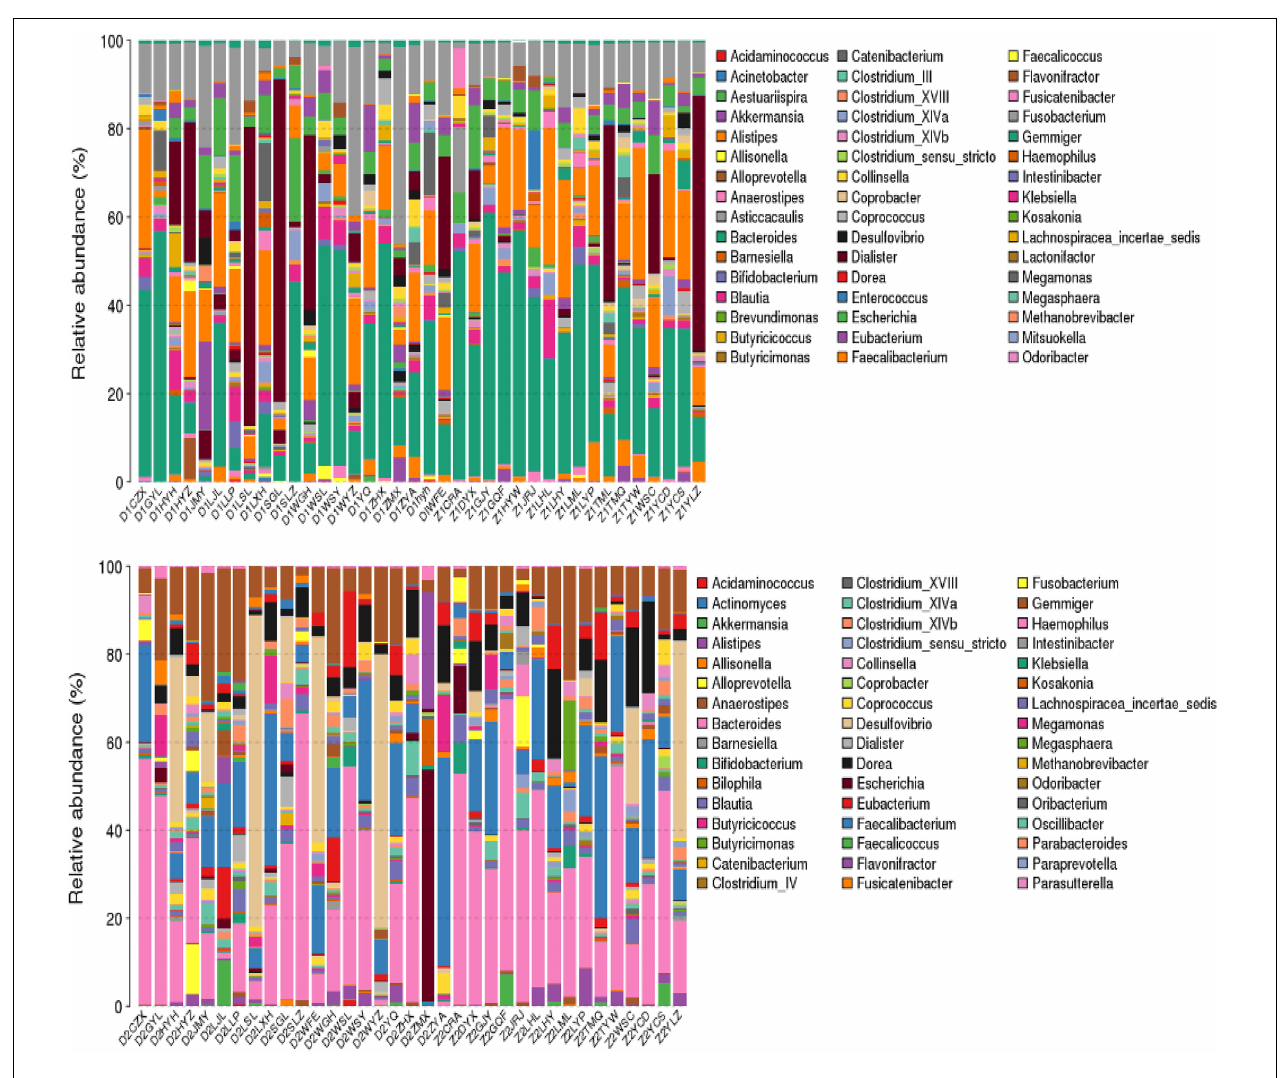
FIGURE 5 | Genus-level changes of intestinal flora in the patients in the Electroacupuncture group and the Control group. (Z1, the Electroacupuncture group before treatment; Z2, the Electroacupuncture group after treatment; D1, the Control group before treatment; D2, the Control group after treatment).